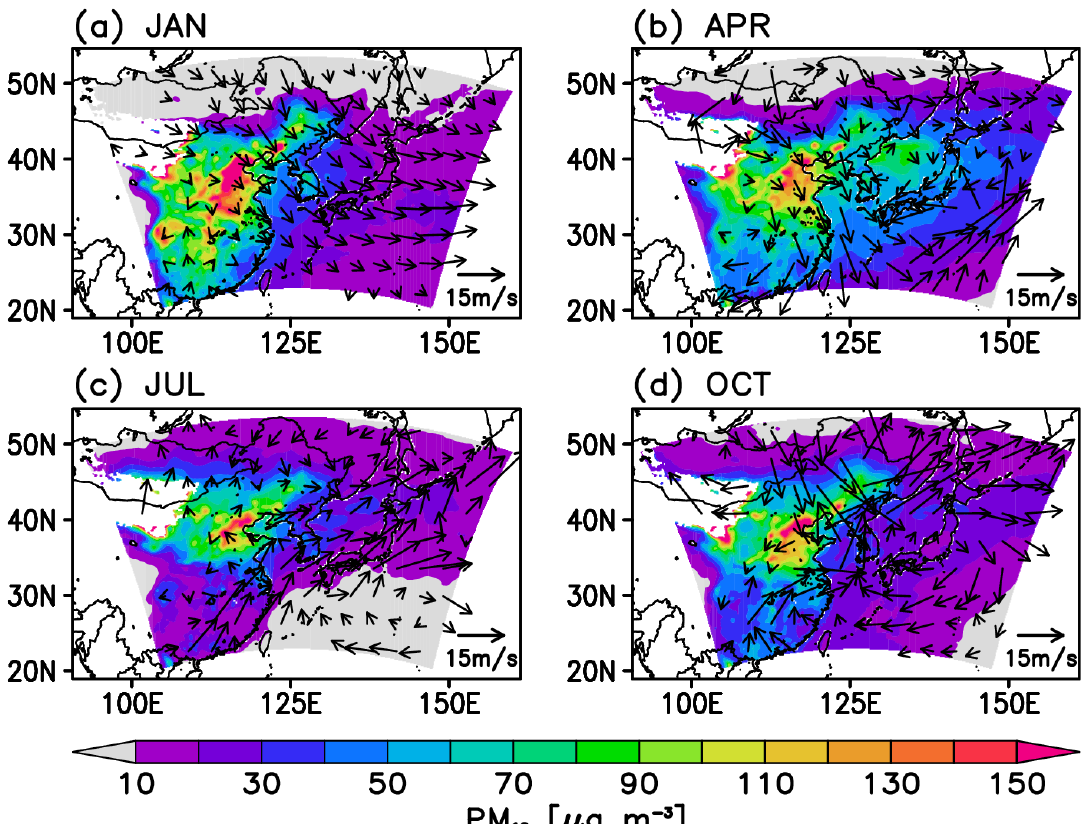
Figure 7. Monthly mean distributions of PM 10 (shaded) and 850 hPa wind (vector) from the DA experiments for ( a ) January, ( b ) April, ( c ) July, and ( d ) October.